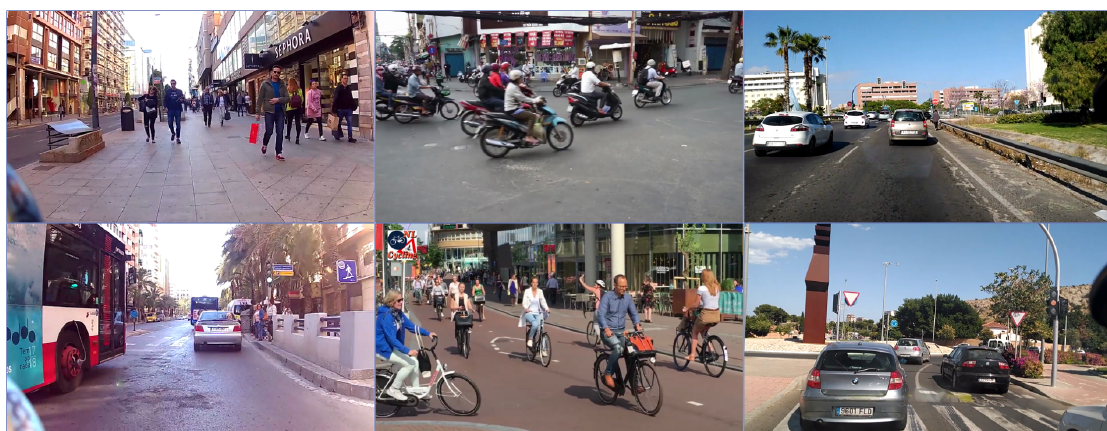
Figure 12. Image samples from the real-life video (test